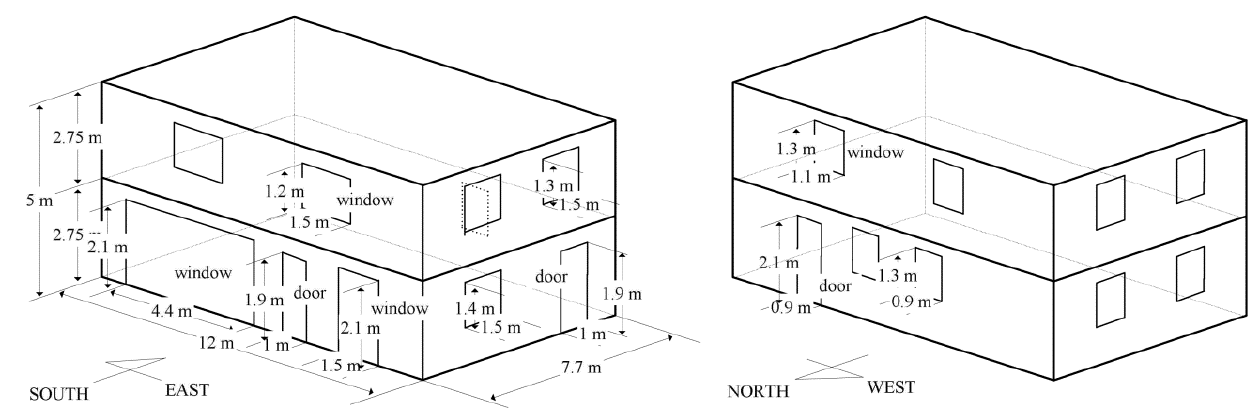
The long axis of the building was in the south and north directions. The net area for each floor was 92.2 m 2 . One wooden door and four windows were installed on both the south-facing and north-facing façades. The east-facing façade contained three windows and one door. Four windows were installed on the west-facing façade. No windows existed on the